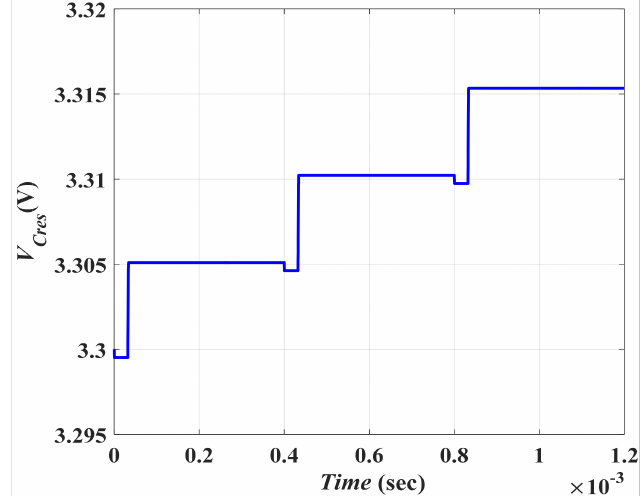
Figure 14. Variation of V Cres during multiple cycle of the input vibration signal.